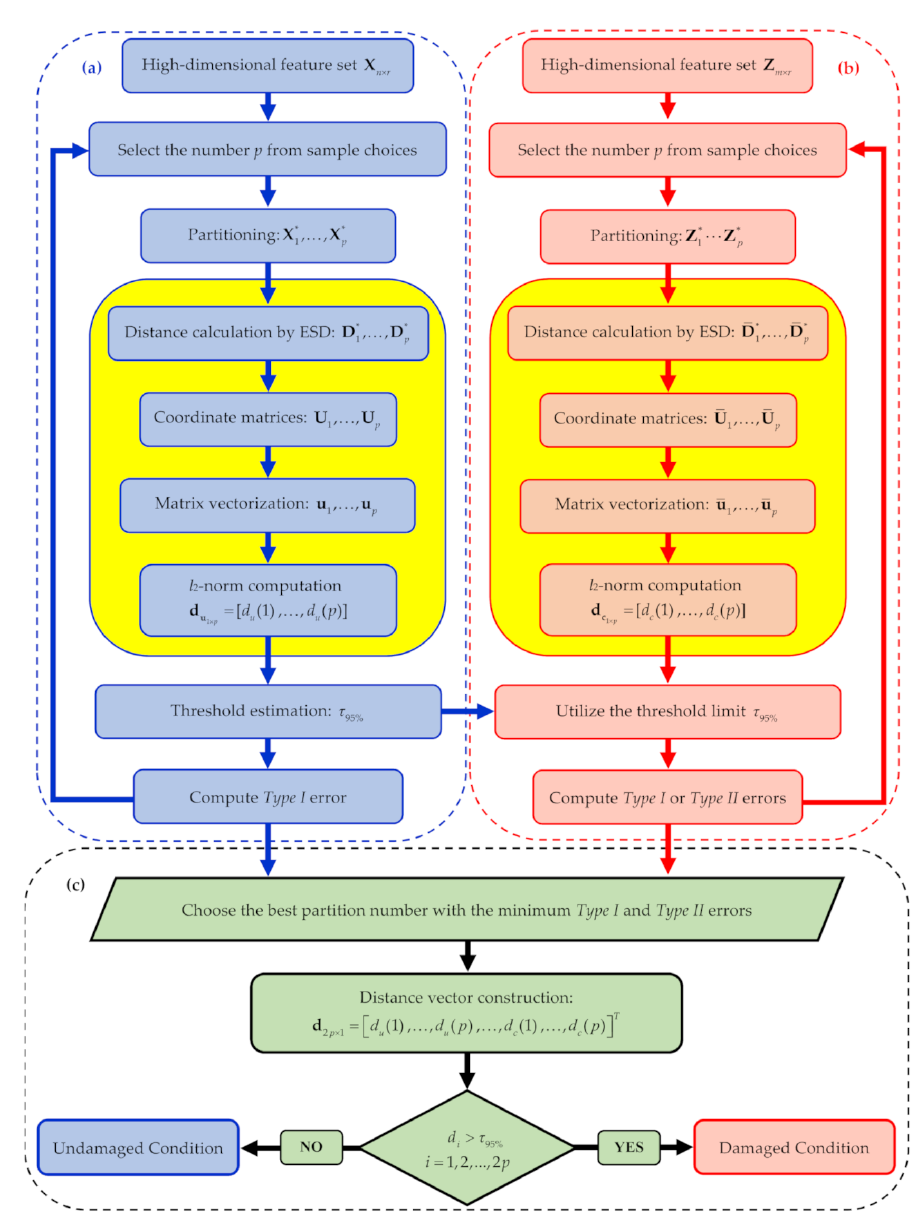
Figure 1. Graphical flowchart of the proposed classical multidimensional scaling (CMDS)-based structural health monitoring (SHM) method: ( a ) iterative loop related to the undamaged condition, ( b ) iterative loop related to the current state, ( c ) decision-making strategy based on the chosen number p of partitions. The yellow boxes are specifically related to the CMDS